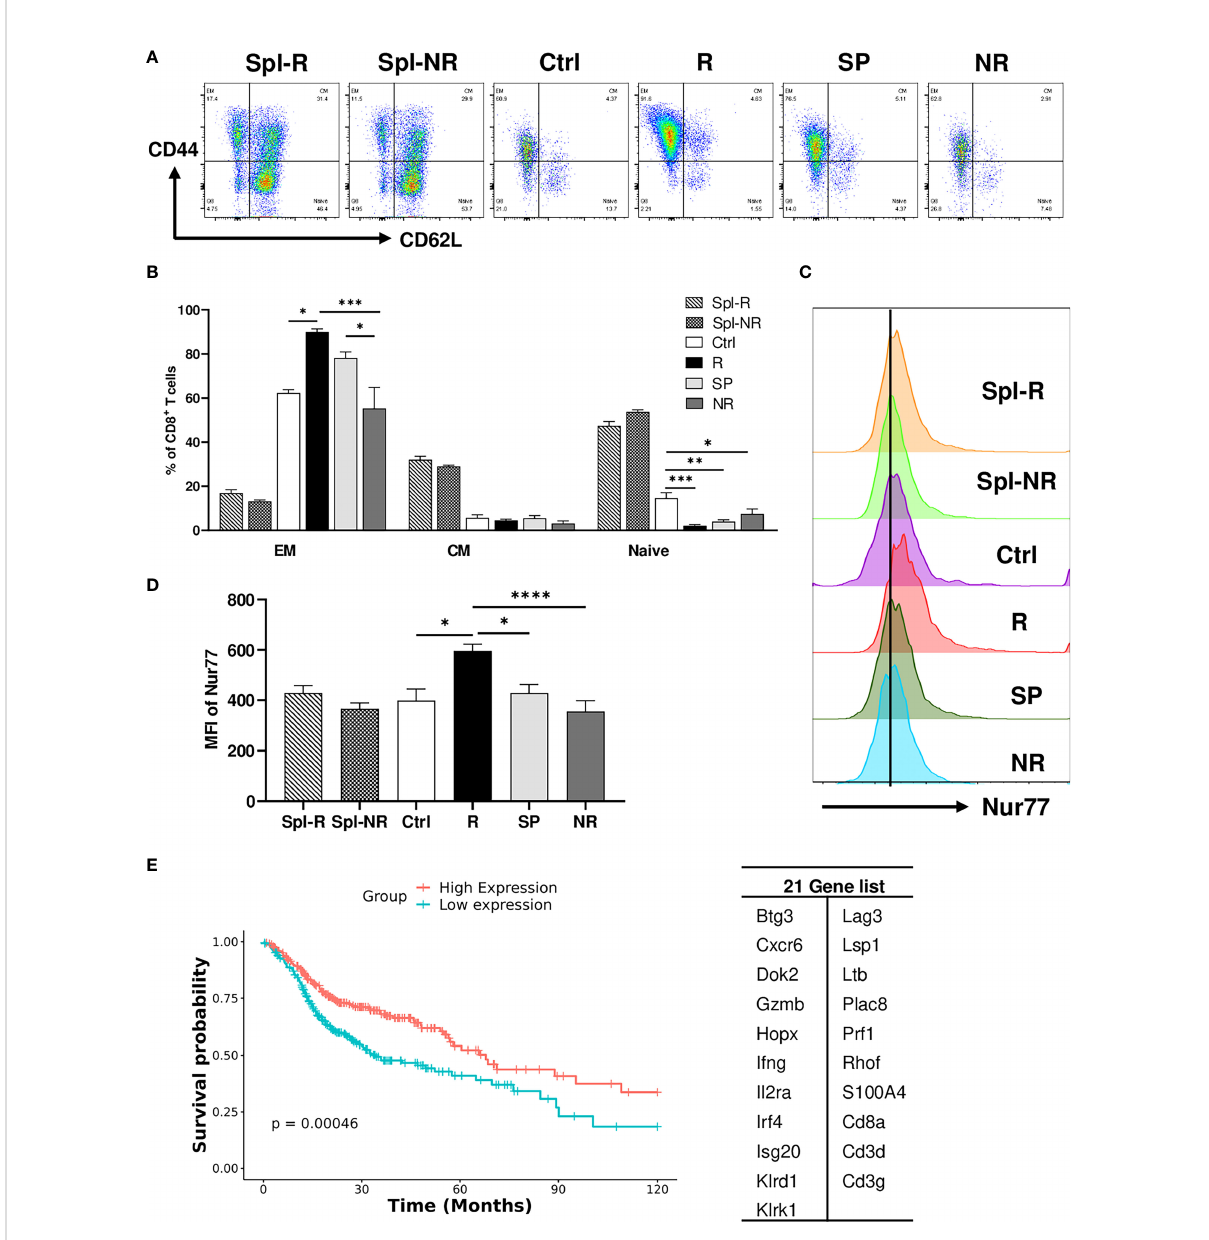
FIGURE 8 Validation of single-cell sequencing data. (A, B) Representative fl ow plots (A) and percentages (B) of different memory CD8 T cell populations in Spl-R, Spl-NR, Ctrl, R, SP and NR groups. EM: effector memory (CD44 + CD62L − ), CM: central memory (CD44 + CD62L + ) and naïve (CD44 − CD62L + ). (C, D) Representative fl ow plots (C) and mean fl uorescence intensity (MFI) (D) of Nur77 (Nr4a1) expression in CD8 T cells from Spl-R, Spl-NR, Ctrl, R, SP, and NR groups. Data were presented as mean ± SEM (Spl-R: n=10; Spl-NR: n=12; Ctrl: n=7; R: n=10; SP: n=8; and NR: n=12). Statistical signi fi cance was calculated with one-way ANOVA followed by Tukey ’ s multiple comparisons test (* P <0.05; ** P <0.01; *** P <0.001; **** P <0.0001). (E) Genes more upregulated in responder top TCR clonotypes (n=21, right) were used to score HNSCC patients (n=502). Patient data are derived from HNSCC TCGA Pan-Cancer Atlas RNA sequencing data (RNA_Seq_v2_mRNA_median_all_sample_Zscores) (cBioPortal). Scores for the 21 genes were calculated as the Mean of Zscore transformed data of mRNA expression of genes, and then patients were grouped into high-expression (if score > the median score) or low-expression (if score ≤ the median score) and analyzed for